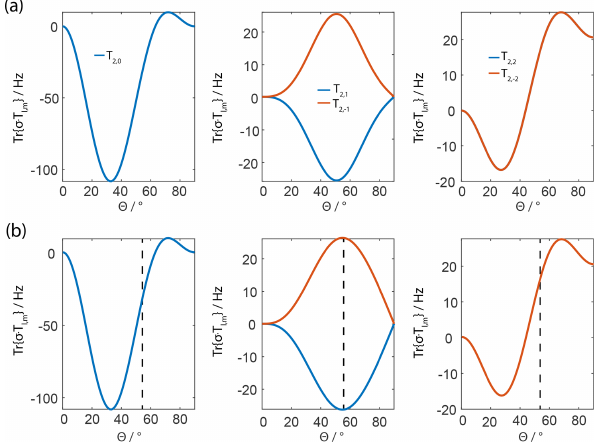
Figure 2. Magnitude of the third-order spin-tensor operators re- sulting after FSLG irradiation only assuming a single homonuclear dipolar coupling from numerical simulations (a) and analytical cal- culations (b) showing the same tensor components. The simulation parameters for the powder orientations and the MAS-to-modulation frequency ratio are the same as shown in Fig. 1. The remaining terms vanish either around 60 ◦ for the T 2 , 0 term or around 40 ◦ for the T 2 , ± 2 term. It is interesting to note that with the traditional FSLG scheme none of the third-order terms